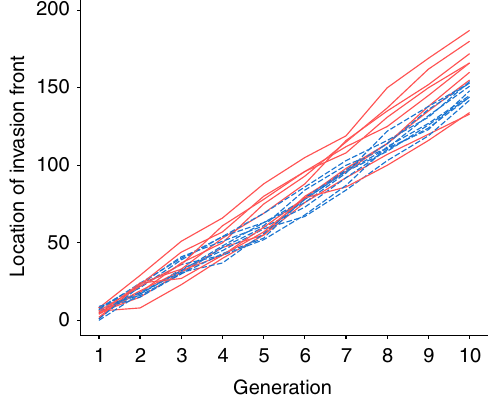
Figure 2 | Spread dynamics of spatially sorted and shuffled invasion replicates. Lines show raw invasion trajectories (invasion extent through time) for all replicates in the spatially sorted (red solid lines) and shuffled (blue dashed lines) invasions (nine replicates each). Spatially sorted replicates invaded faster, on average, than shuffled replicates (model